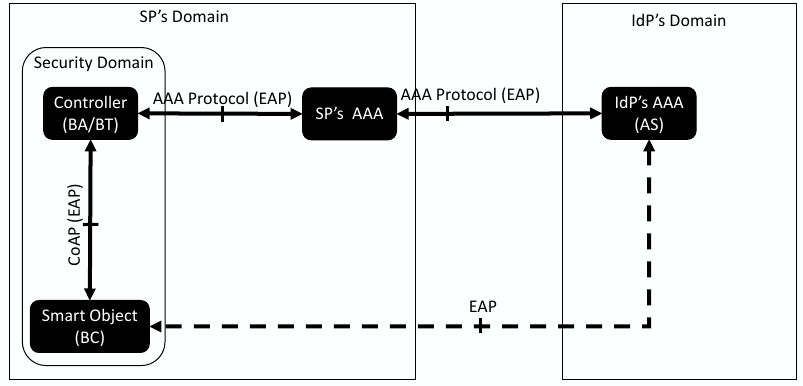
Figure 3. The constrained application protocol (CoAP)-EAP